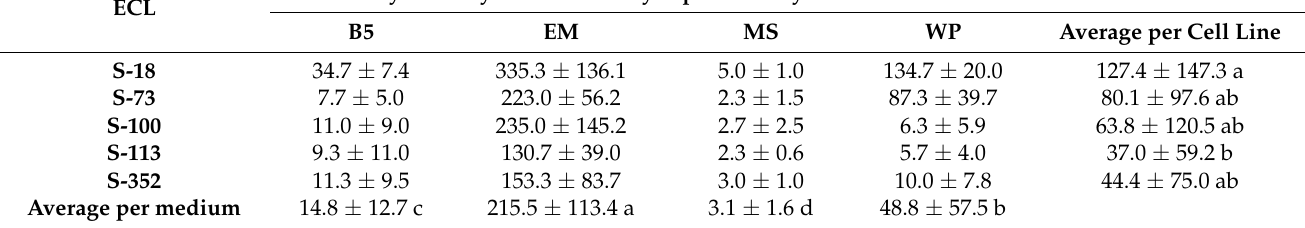
Table 1. Effect of basal salts (BS) of medium on somatic embryo maturation efficiency of sugi embryogenic cell lines (ECLs). Data are presented as the mean ± SD (standard deviation) of the number of cotyledonary somatic embryos per plate from three replicates for each ECL matured on media containing different BS